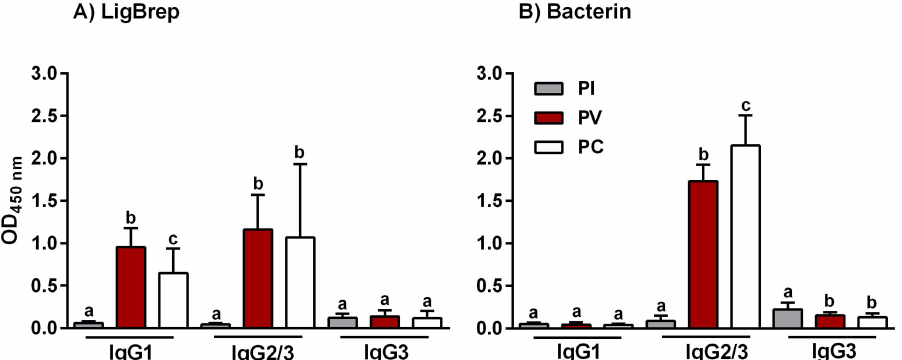
Fig 5. IgG subclasses induced by vaccination with LigB(131–645). IgG subclasses were characterized using ELISAs to determine antibody levels in hamsters immunized with A) rLigB(131–645)/AH or B) bacterin vaccine,see Table 1. Pre-immune (PI), post-vaccination (PV) and post-challenge (PC) serum samples were collectedand characterized with anti-hamster IgG1, IgG2/3 or IgG3 conjugates. The mean OD ± standard deviation(vertical bars) from three independentexperiments are shown. Significancewas determined by one- way ANOVA (Tukey multiplecomparison) analysisand the presenceof lower case letters, where different, indicatesa significantdifference ( P < 0.05)